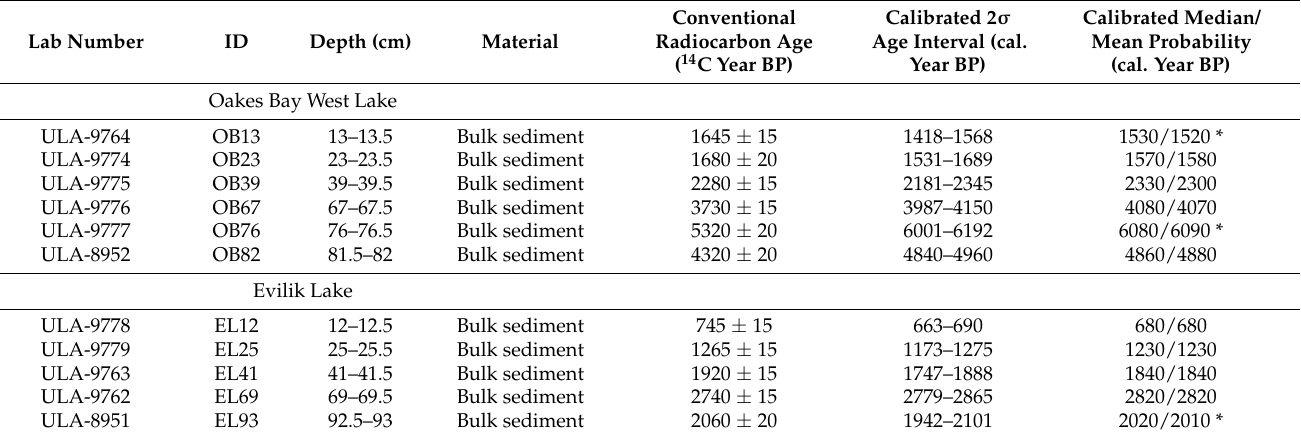
Table 2. Radiocarbon and calibrated ages of sediments from Oakes Bay West Lake and Evilik